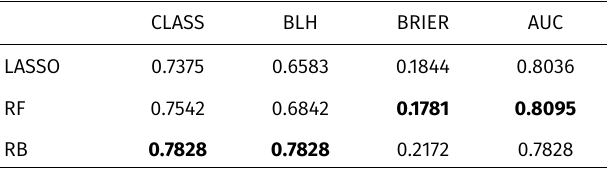
Table 3. Results of the cross validation. Classification Rate, Bernoulli-Likeli- hood-Score, Brier Score and area under the curve. Models are LASSO, random forest and the ranking based reference model. Best values in bold